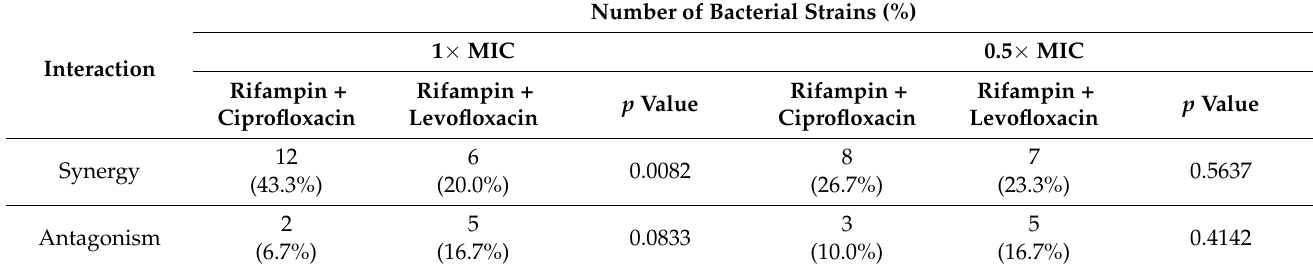
Table 3. Comparison of synergistic and antagonistic interactions of ciprofloxacin and levofloxacin combined with rifampin against methicillin-resistant Staphylococcus aureus